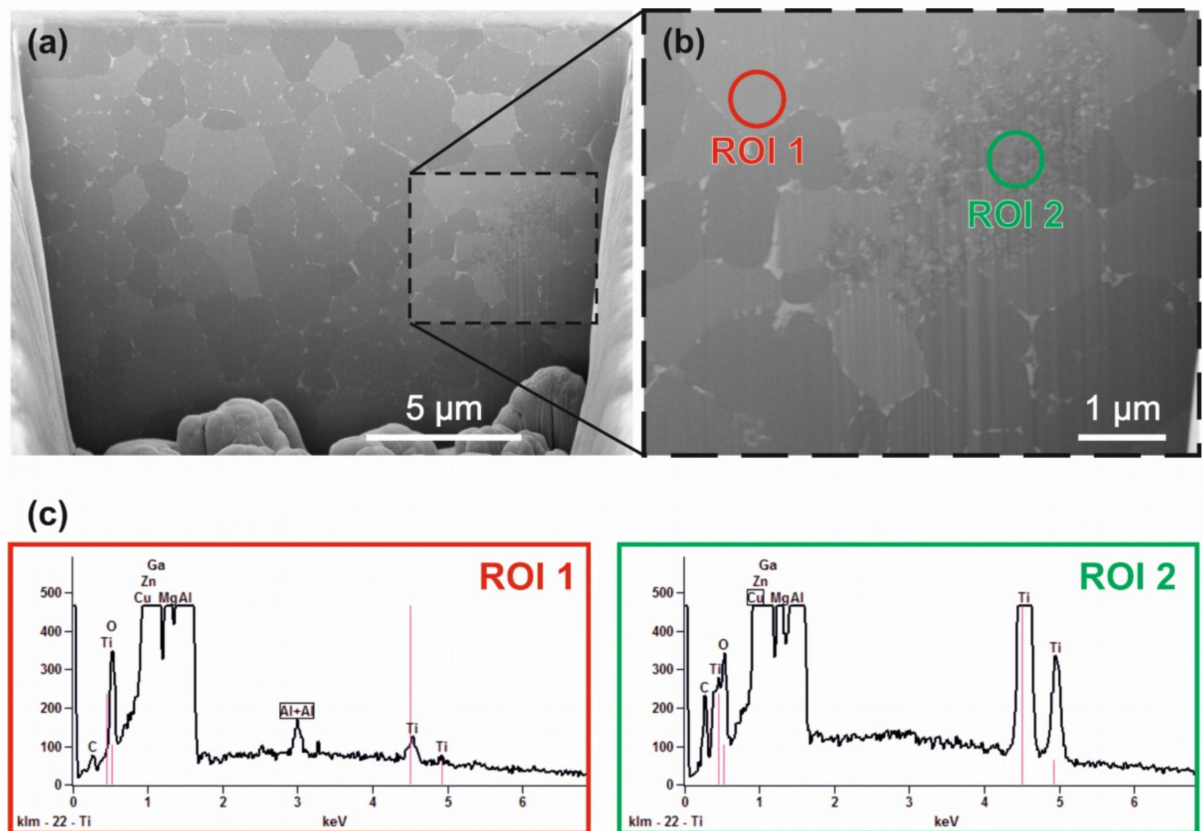
Figure 10. SEM-FiB sample of an as-built specimen made of AA7075/TiC/2.5 giving an insight into the microstructure. ( a ) SEM-SE image of the cut surface in total, ( b ) magnification of the dashed outlined area, ( c ) EDX spectra of the two regions of interest (ROI), indicating an enrichment in Ti within the finer structured region seen in image ( b ).